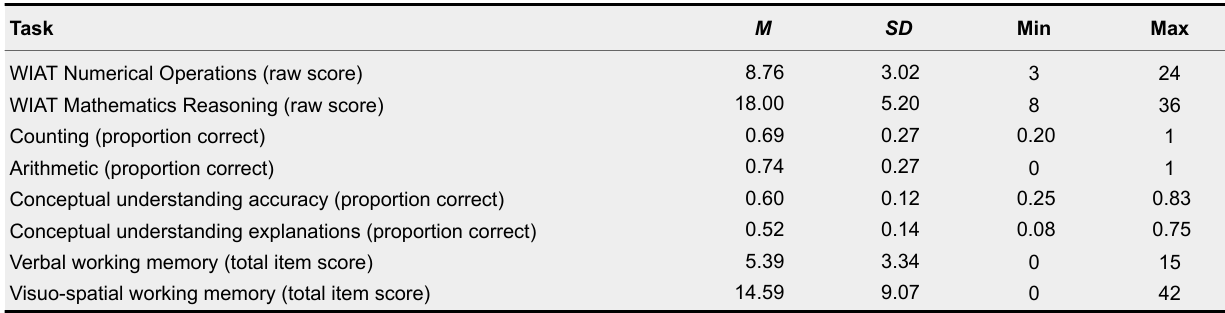
Descriptive Statistics for all